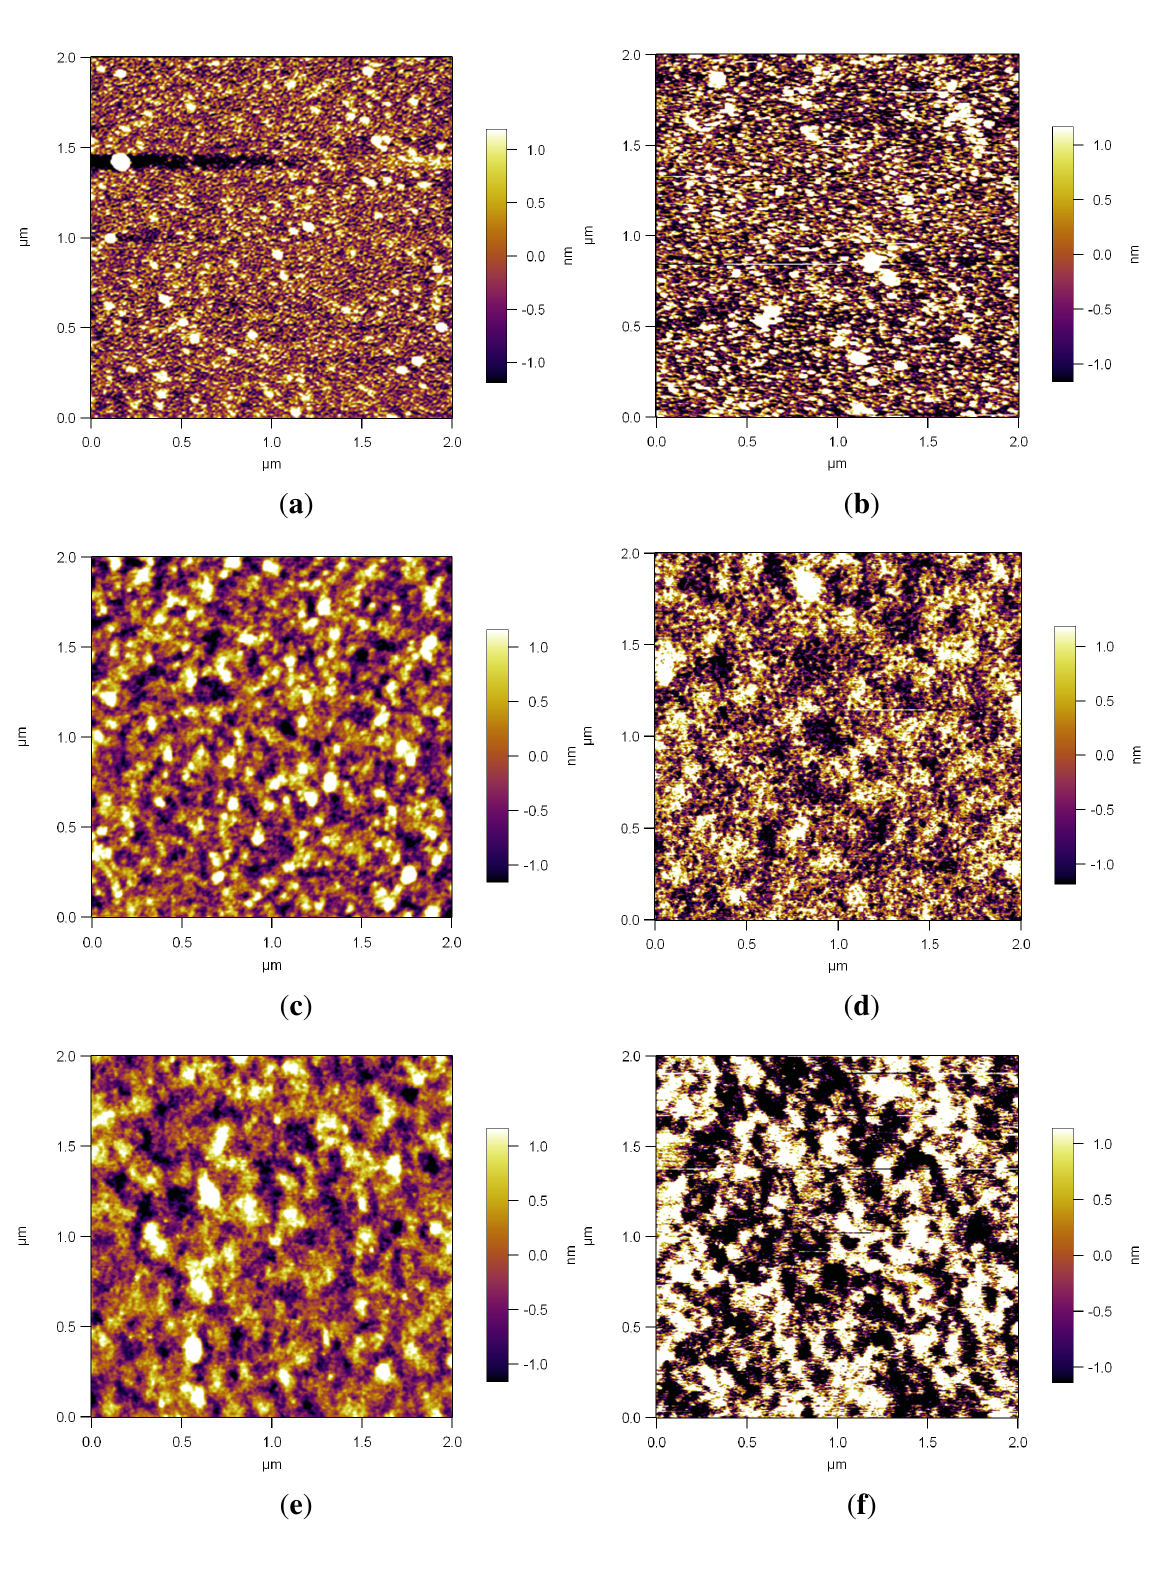
Figure 2. AFM height profiles of Si/PEI/(PSS/PAH) 2 in ambient conditions, roughness 0.71 nm ( a ) and in water, roughness 1.16 nm ( b ); PDMAEMA brushes in ambient conditions, roughness 0.67 nm ( c ) and in water, roughness 1.70 nm ( d ); QPDMAEMA brushes in ambient conditons, roughness 0.70 nm ( e ) and in water, roughness 2.0 nm ( f